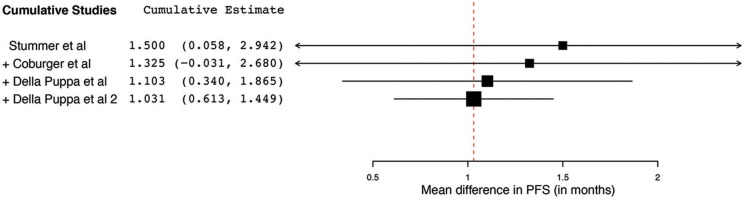
Cumulative regression analysis demonstrating the temporal trend of mean difference in progression-free survival (95% confidence interval [CI]) among patients with primary high-grade glioma treated using 5-aminolevulinic acid–guided surgical resection vs. conventional microsurgical resection. Used with permission from Barrow Neurological Institute, Phoenix, Arizona.